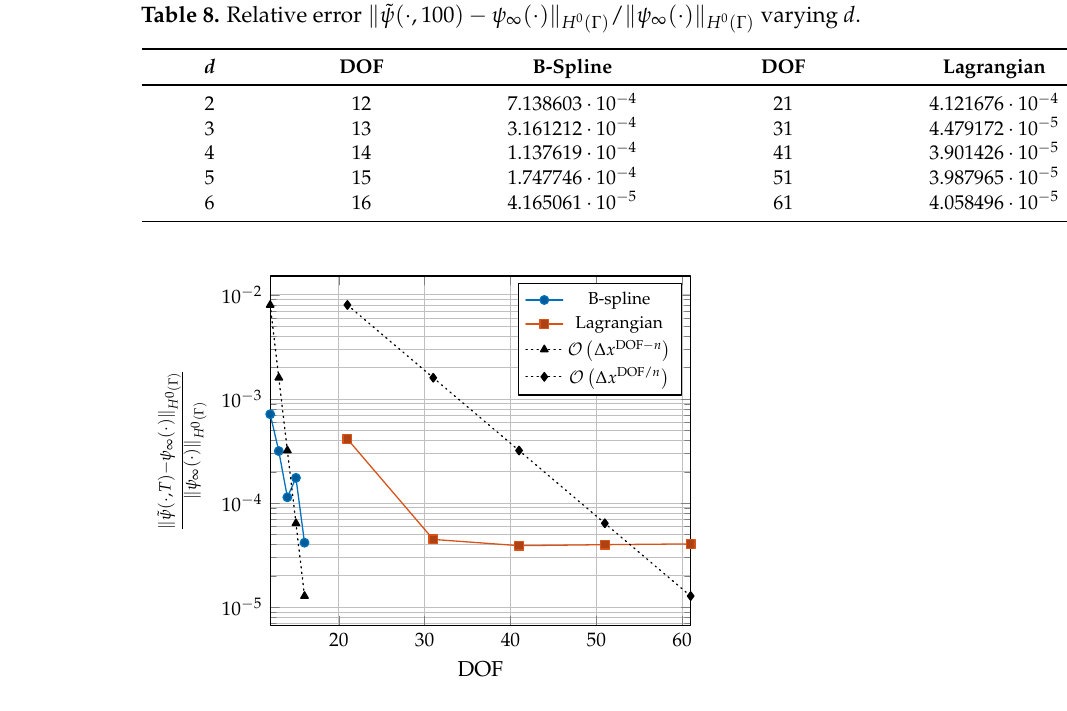
Figure 14. Relative error in H 0 ( Γ ) norm between transient and stationary solution at final time T = 100, versus number of DoFs, having fixed space discretization step ∆ x = 0.2 and time step ∆ t = 0.2.